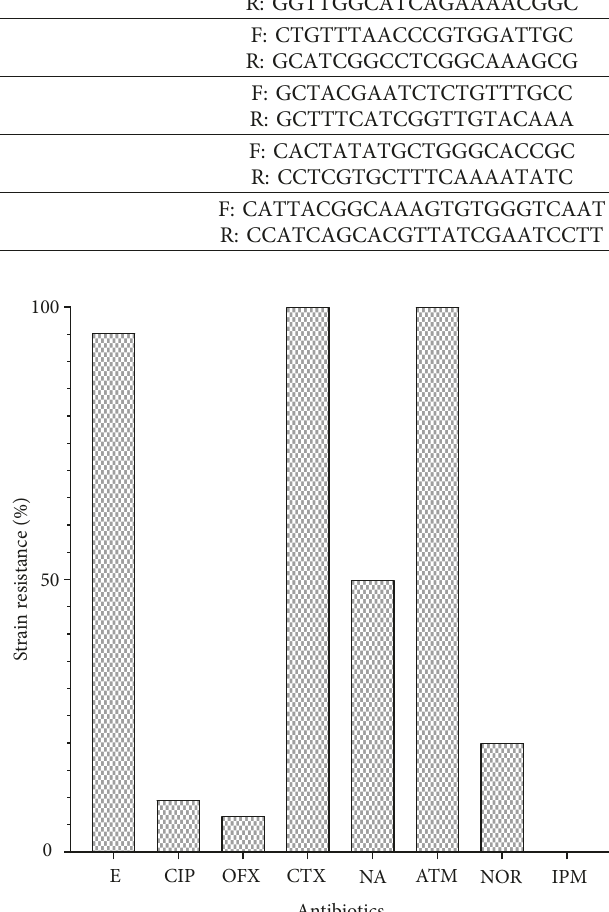
Figure 2: Resistance profile of isolated E. coli strains to antibiotics.